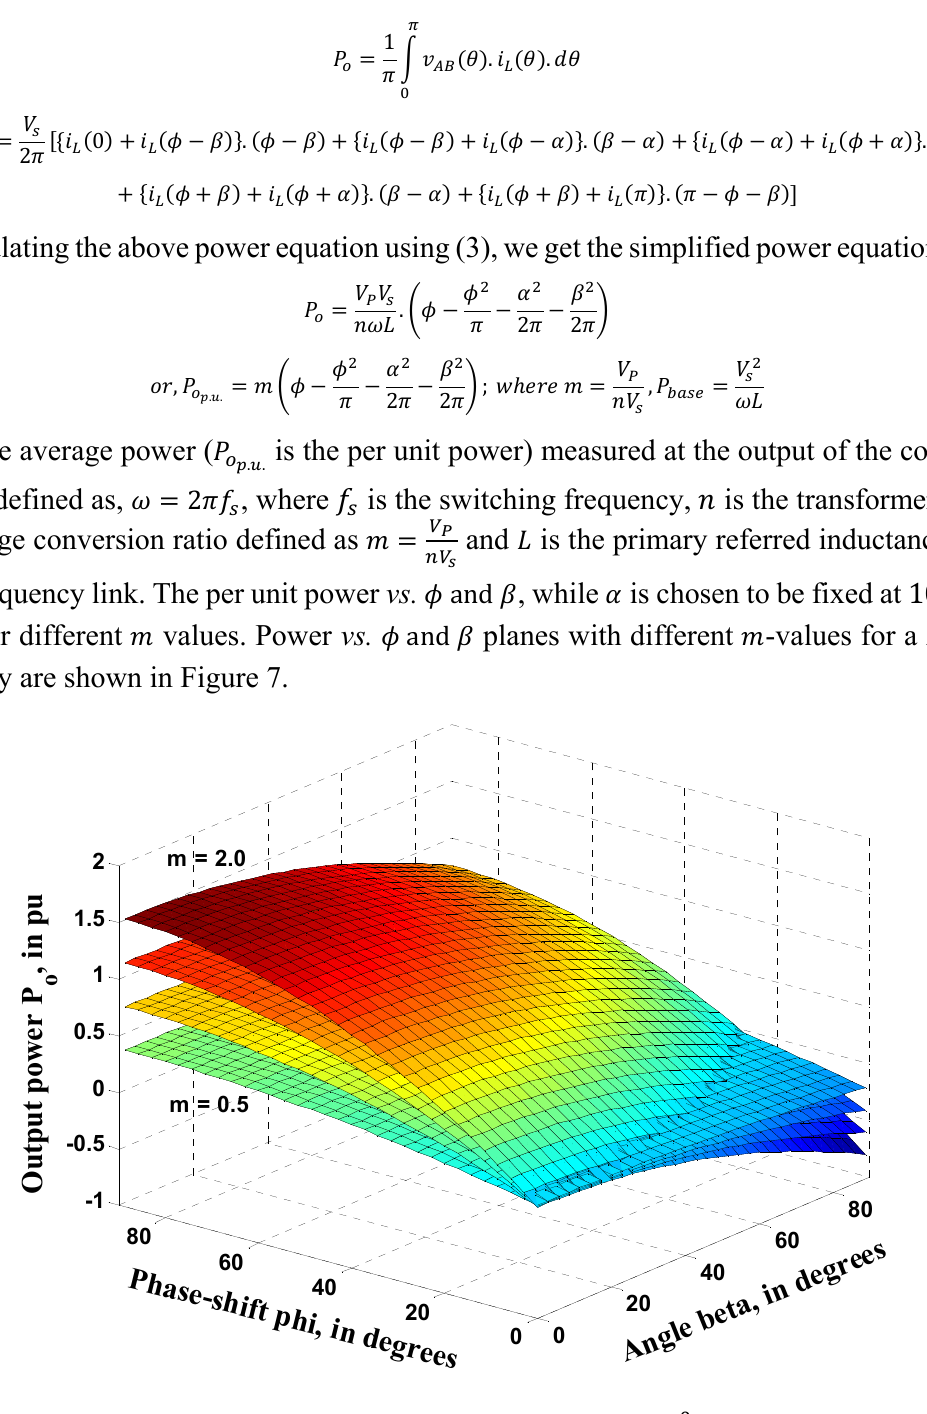
(cid:1874)(cid:1871). (cid:2038) and (cid:2010) with (cid:2009) = 10 (cid:2868) for (cid:1865) = 0.5, 1, 1.5 and (cid:3042) (cid:3043).(cid:3048)